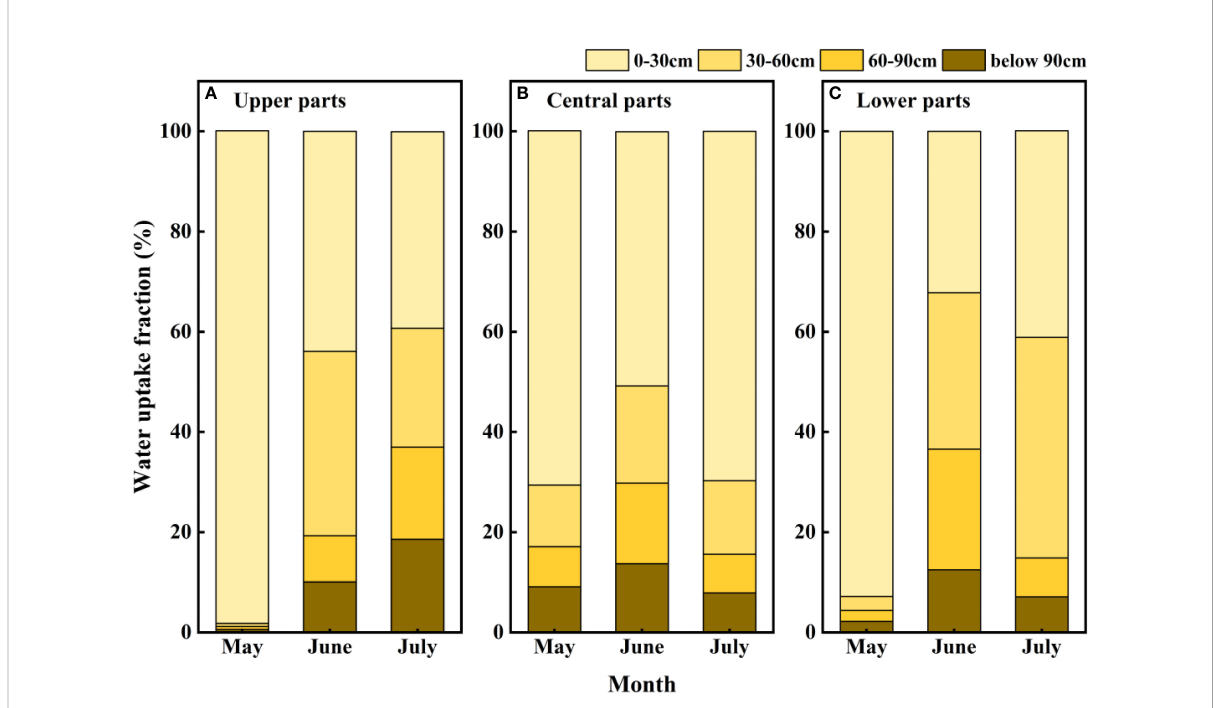
FIGURE 3 Seasonal variations in water uptake proportions from different soil layers for Ferula bungeana growing at different sites on mega-dunes. (A – C) present data for the upper, central parts, and lower parts of mega-dunes, respectively. The data were obtained using the iso-source